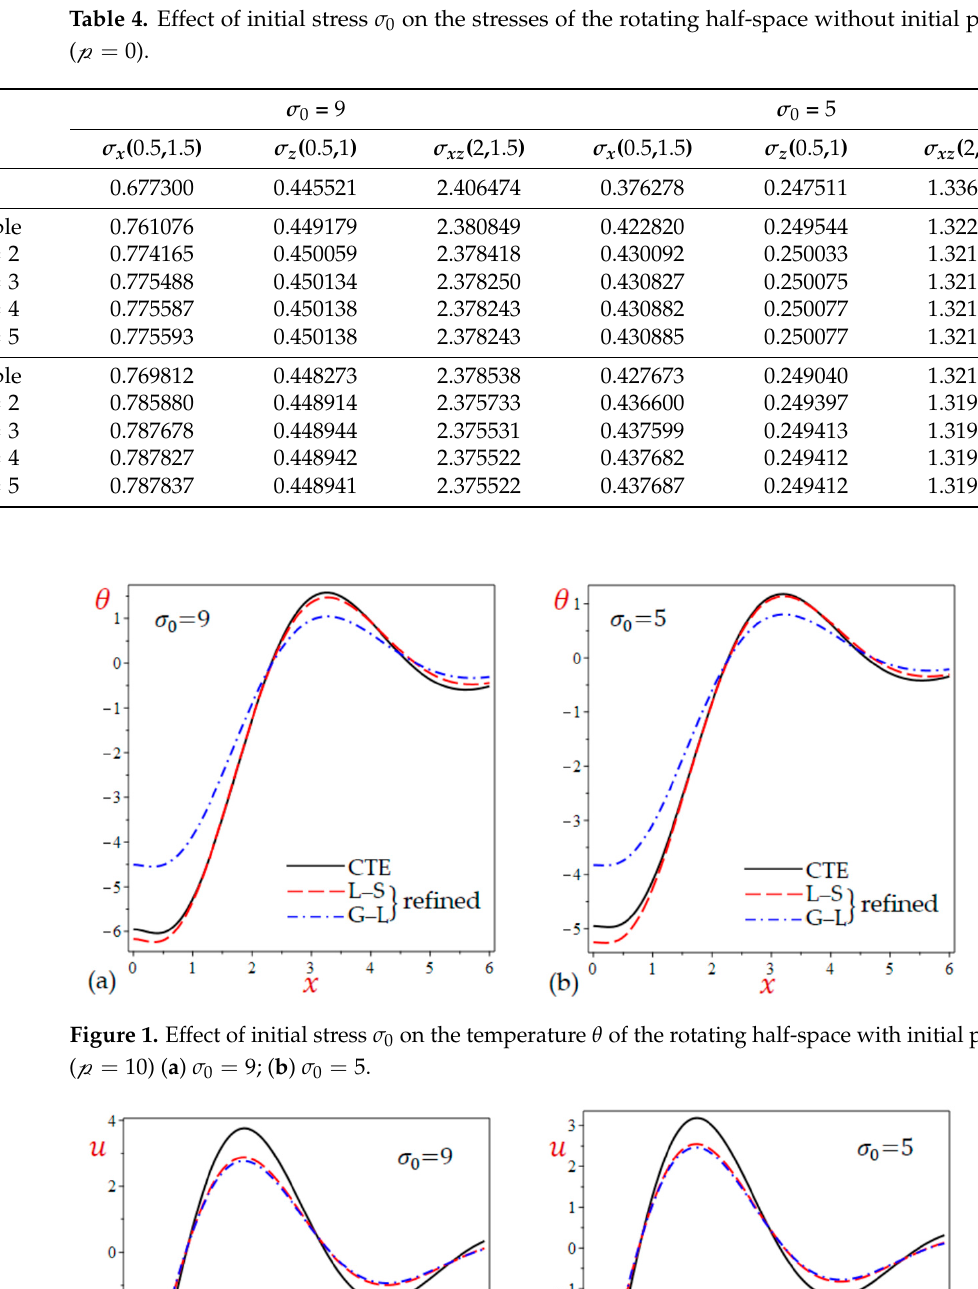
Figure 3. Effect of initial stress 𝜎 (cid:2868) on the vertical displacement 𝑤 of the rotating half-space with initial pressure ( 𝓅 = 10 ) ( a ) 𝜎 (cid:2868) = 9 ; ( b ) 𝜎 (cid:2868) = 5 .